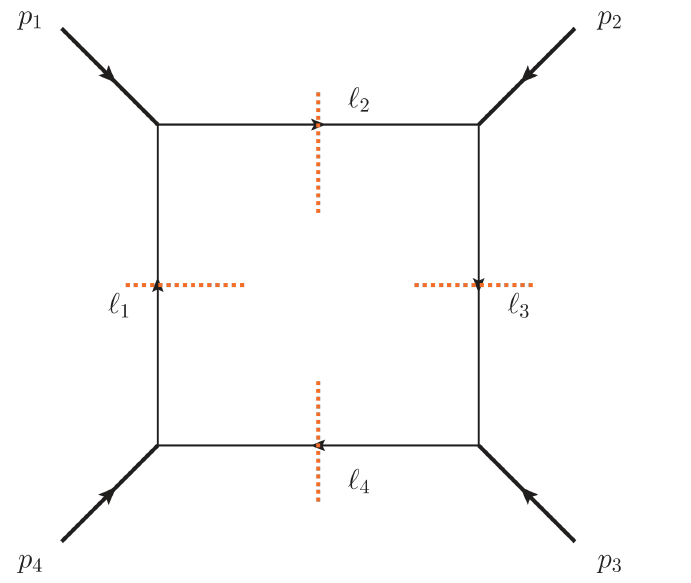
Figure 1 . A quadruple-cut diagram for the all-plus amplitude discussed in the text. Bold external lines represent physical gluons or gravitons, depending on the